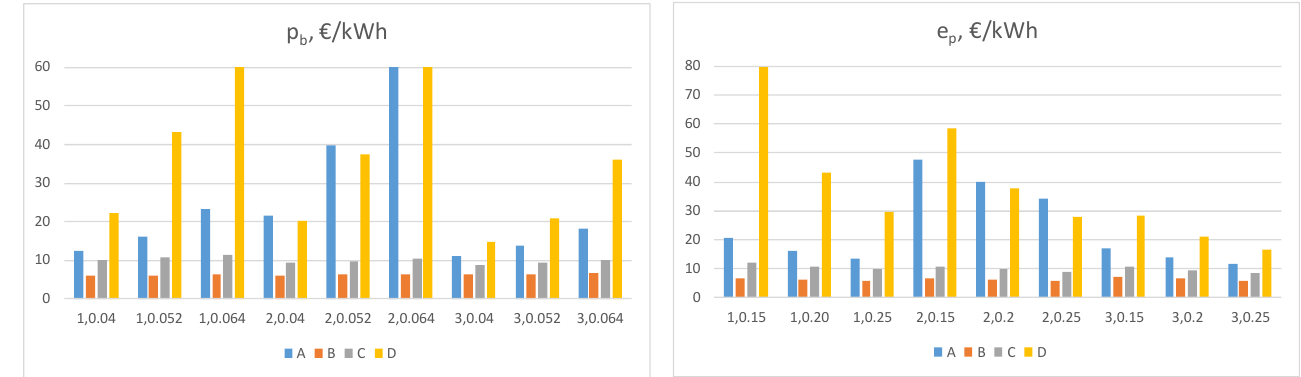
Figure 4. Sensitivity analysis of the proposed configurations for each site: SPB (years) as a function of the biomass p b (0.04, 0.052, 0.064) and electricity purchase e p prices (0.15, 0.20, 0.25) in €/kWh for the three locations (1–3) and four configurations (A – D).